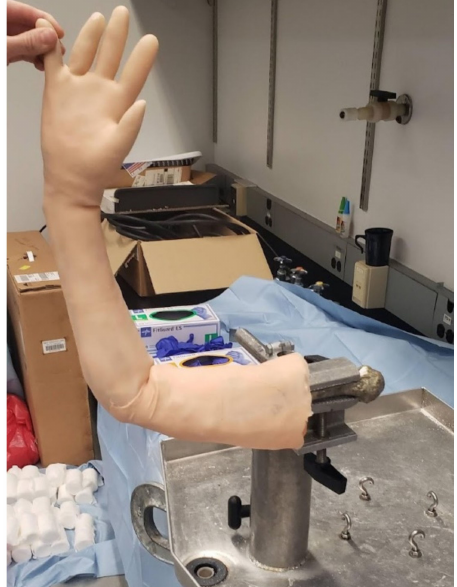
Figure 8. Photograph showing our phantom mounted in a vice to replicate a stationary patient in preparation for inducing